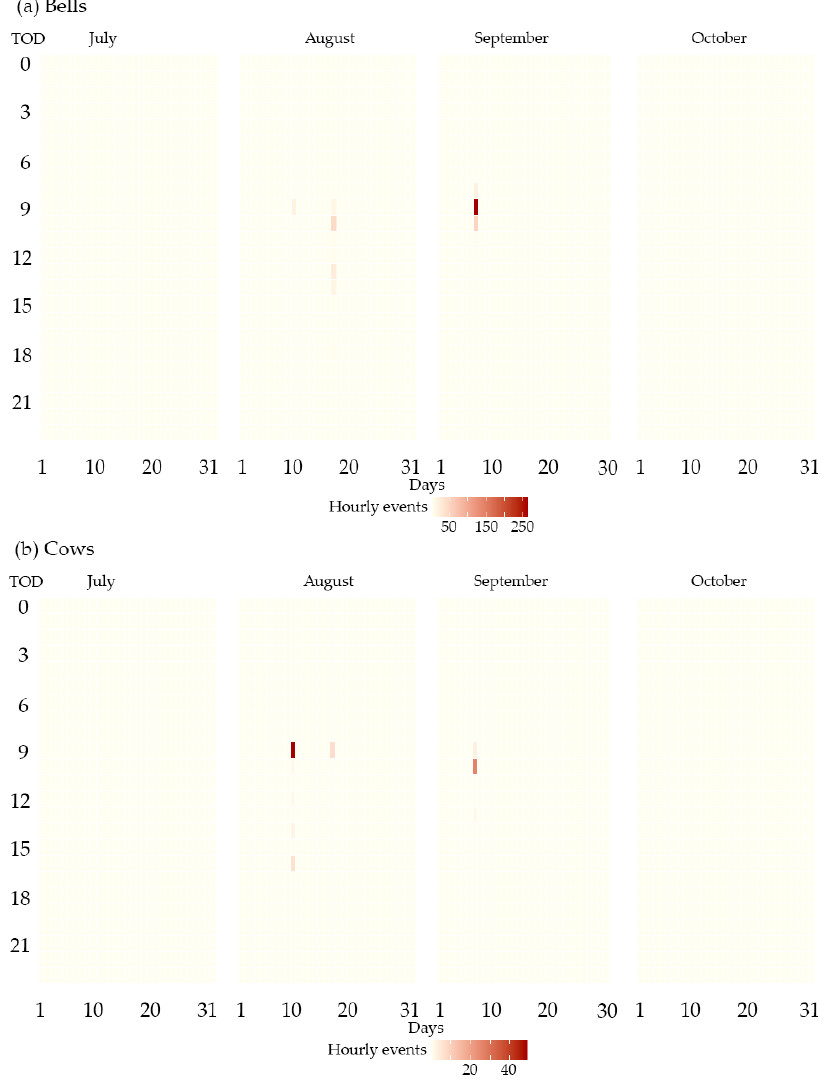
Figure 3. Diel and seasonal distribution of livestock bells ( a ) and cow lowing ( b ) at Zaras site. Y-axis rows represent time of the day (TOD; 0 am to 23 pm). X-axis columns represent days of the study period (1 July to 31 October).